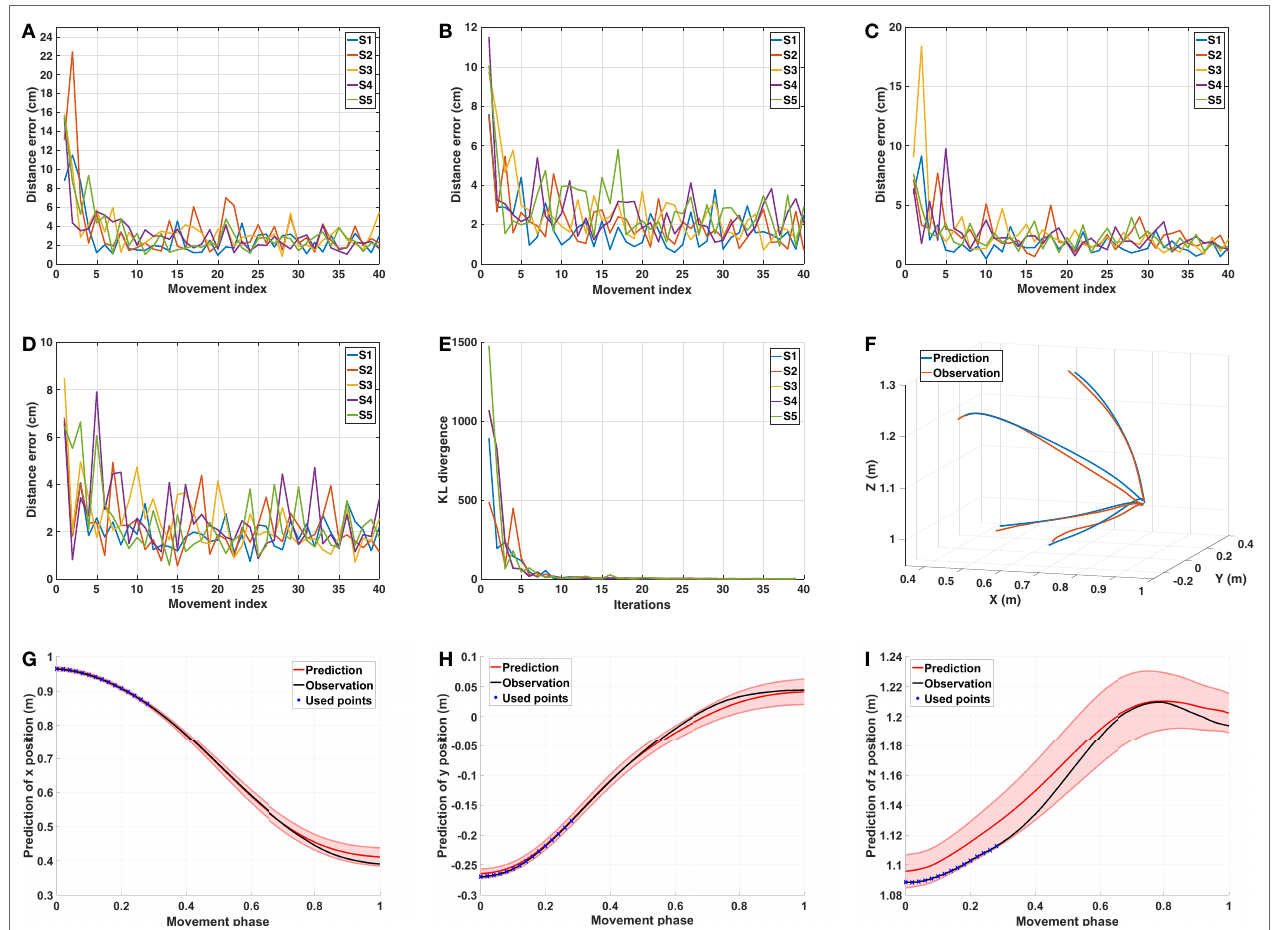
FIGURE 10 | Results of predicting with the ProMPs. (A–D) Distance error between the observations and the ProMPs predictions of five subjects for target one to target four. The errors converge after several updates. (E) KL-divergence of comparing the updated distribution with the previous one for target one. It can be observed that after 10 iterations the value is quite small, which indicates that the distribution converges. (F) The ProMPs predictions and the observations in the last iteration of subject one for all four targets. (G–I) The ProMPs predictions in the last observation of subject one for target one. Each plot presented the mean and the variance of x , y , z positions in Cartesian space,